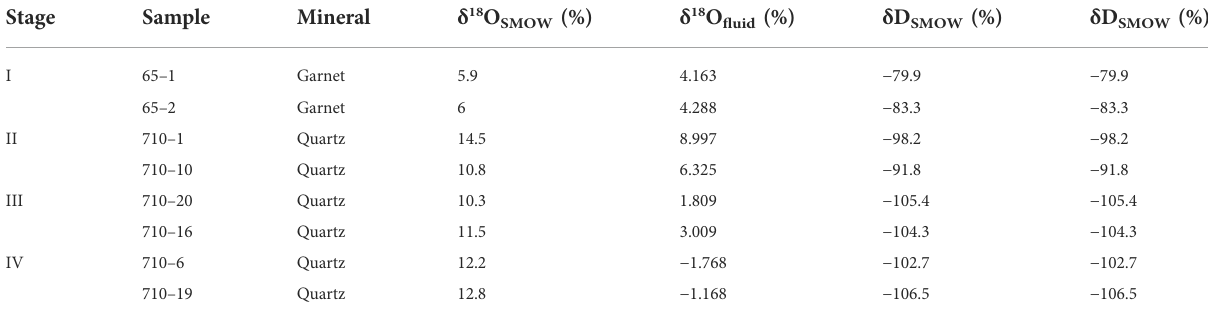
TABLE 3 H – O isotope data of garnet, scheelite, and quartz from the Shibaogou Mo – Pb – Zn deposit.